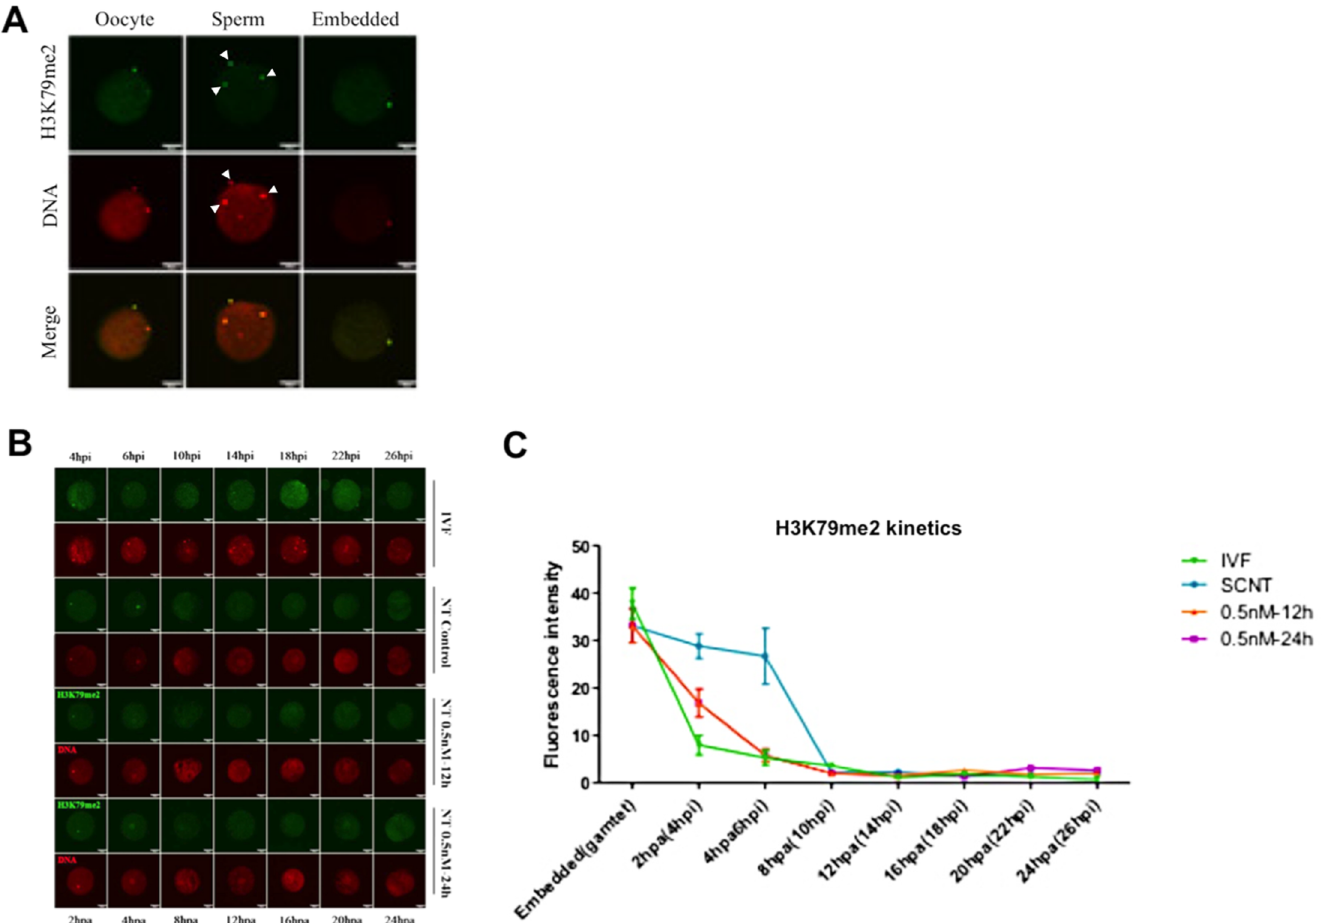
Fig 3. DOT1L inhibition reduces H3K79me2 level in porcine SCNT pronuclear embryos. (A) Representative images of H3K79me2in porcine MII oocytes, sperms and cytoplasm-donor cell reconstructed coupletsimmunostained with anti-H3K79me2 antibody.Primary antibodywas localizedwith Alexa Flour 488-conjugated secondary antibody (green). DNA was stainedwith propidiumiodide(red). Bottom panelsshowedthe mergedimages (yellow) betweenH3K79me2signals(green) and DNA staining(red). White arrowheaddenoteslocalization of H3K79me2and DNA in sperm. Scale bars = 50 μ m. (B) Representative images of porcine IVF and SCNT pronuclearembryos at different developmental stages. IVF embryos were fixed from 4 hpi to 26 hpi simultaneously correspondingto different stages from 2 hpa to 24 hpa in SCNT embryos. All embryos were immunostained with anti-H3K79me2 antibody. Primary antibodywas localizedwith Alexa Flour 488-conjugatedsecondary antibody(green). DNA was stained with propidiumiodide(red). Scale bars = 50 μ m. (C) Quantificationof H3K79me2 fluorescence intensity betweenIVF and SCNT pronuclear embryos from A. Green line denotesIVF group, blue line represents SCNT control group, yellow line indicatesSCNT embryos treated with 0.5 nM EPZ for 12 h and purpleline marks SCNT embryos treated with 0.5 nM EPZ for 24 h. Data are expressedas mean ± S.E.M.